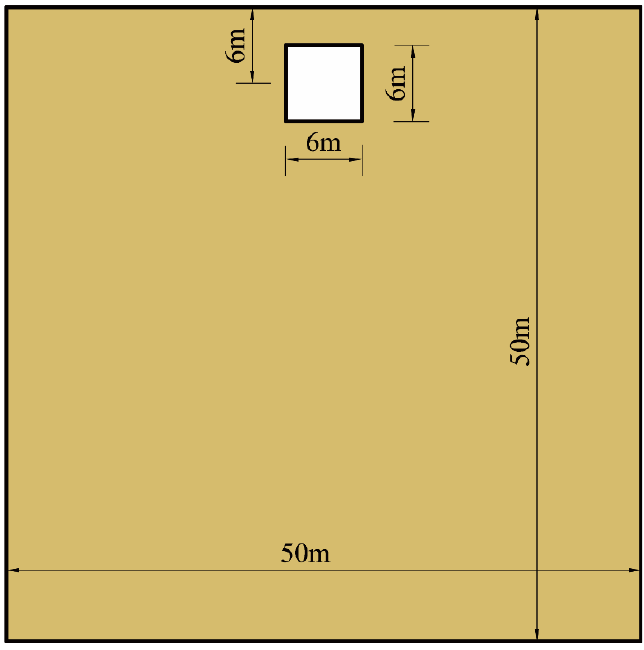
Figure 1. The tunnel with an embedment depth of 6 m.